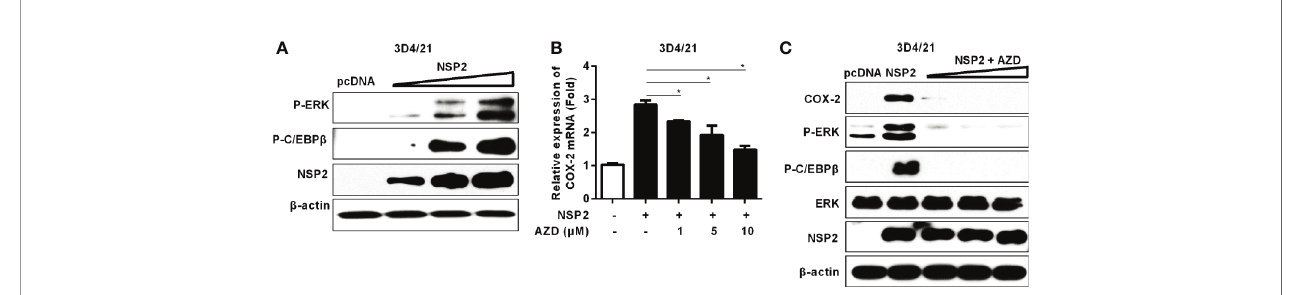
FIGURE 5 | Analysis of the role of NSP2 in activating MEK1-ERK1/2-C/EBP b pathway. (A) 3D4/21 cells were transfected with different amounts of NSP2 protein expression vector. At 24 hours post-transfection, harvested cells were lysed for Western-blot to examine levels of p-ERK, p-C/EBP b , and NSP2. (B, C) 3D4/21 cells were transfected with NSP2 (0.5 m g). At 6 hours after transfection, cells were treated with DMSO or indicated concentrations of AZD. At 18 hours post-inoculation, cells were collected and subjected to the real-time PCR to measure COX-2 mRNA level (B) and Western-blot to detect COX-2, p-ERK, p-C/EBP b , ERK, and NSP2 protein levels (C) . Data are representative of three independent experiments (mean ± SEM). Statistical analysis was performed by Student ’ s t -test. *, P < 0.05 .